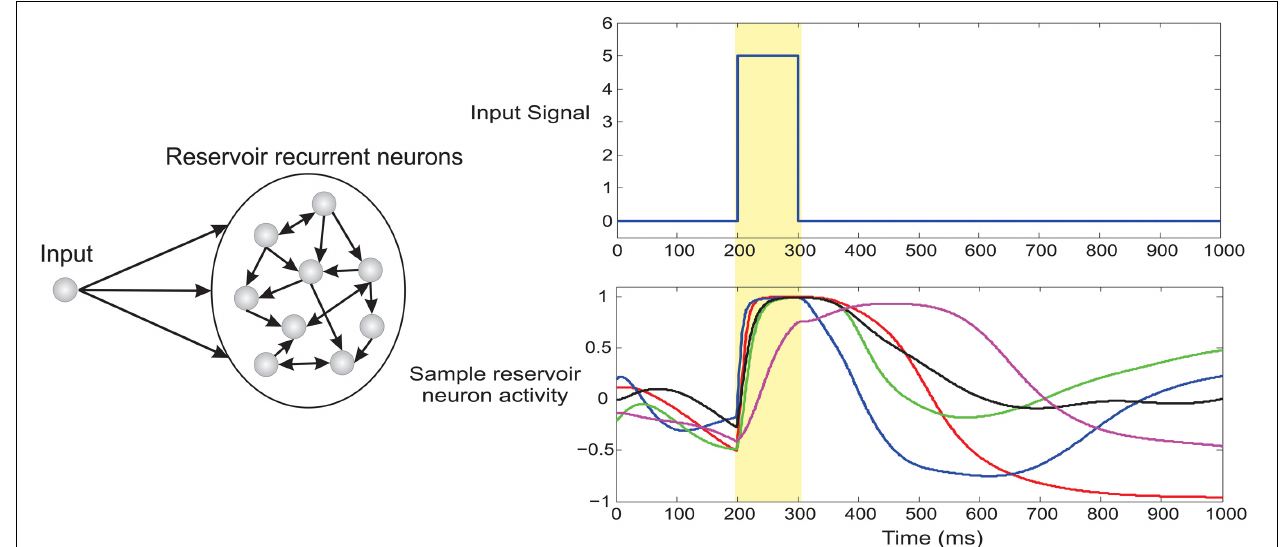
FIGURE 4 | Fading temporal memory in recurrent neurons of dynamic reservoir. The recurrent network (100 neurons) was driven by a brief 100 ms pulse and a fixed auxiliary input of magnitude 0.3 (not shown here). Spontaneous dynamics then unfolds in the system based on Equation 9. The lower right panel plots the activity of 5